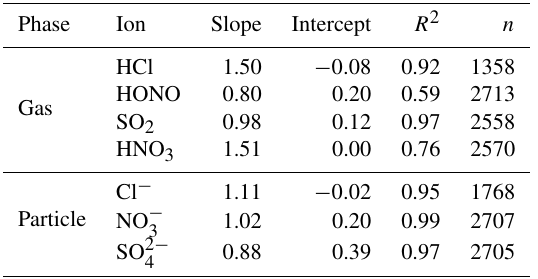
Table 5. Orthogonal regression parameters of the comparison of inorganic compounds measured by the MARGA and Compact IC in Melpitz for 1 year. Scatter plots are given in Figs. S17 and S18.